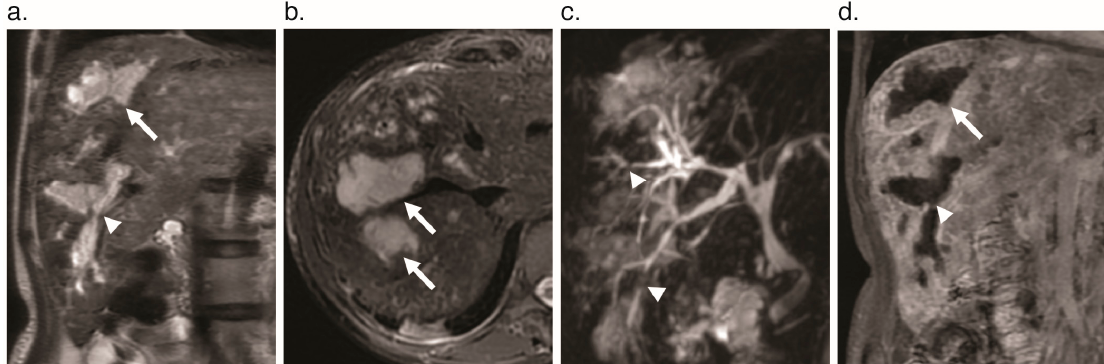
Figure 10. Ischemic cholangiopathy in a 36-year-old woman with HHT. Marked dilation of the intrahepatic bile ducts (arrows) and focal stenoses of the biliary tree (arrowheads) are seen on ( a ) coronal T 2 -weighted SSFSE MR images, ( b ) axial T 2 -weighted SSFSE MR images, ( c ) coronal MRCP maximum-intensity projection image, and ( d ) coronal T 1 -weighted gadolinium-enhanced MR image. (SSFSE = single shot fast spin echo, MRCP = magnetic resonance cholangiopancreatography).